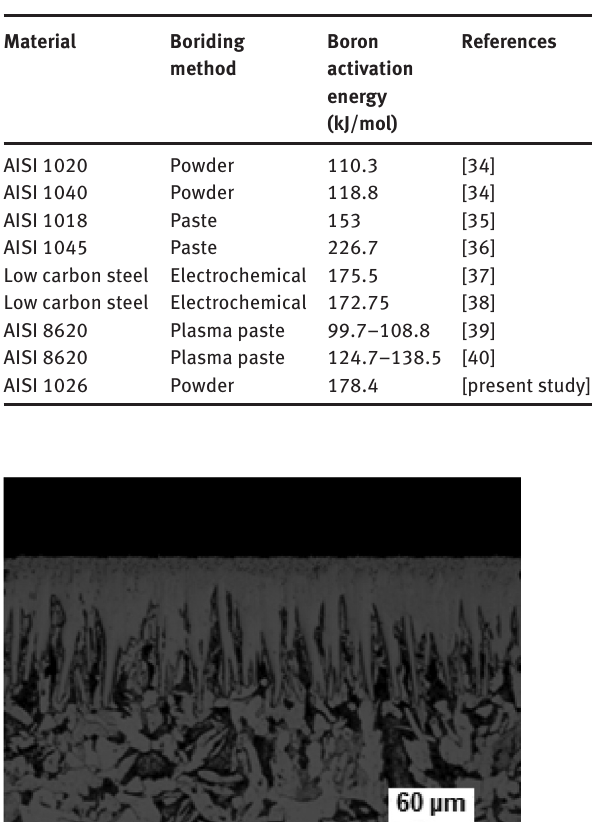
Table 2: A comparison of boron activation energy of AISI 1026 steel with other steels using different boriding methods.